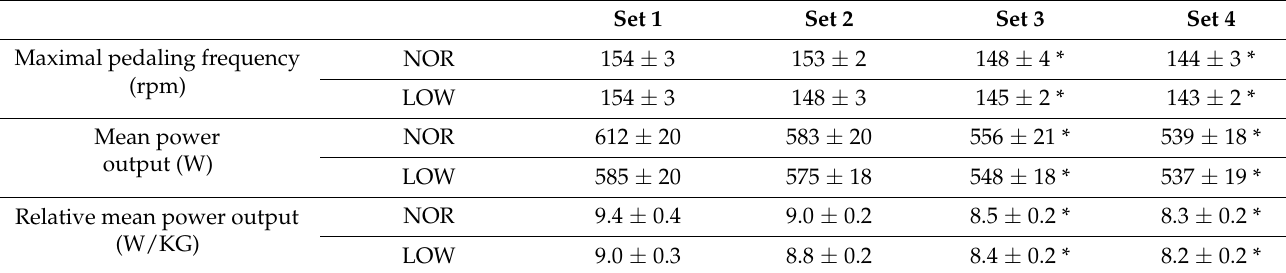
Table 1. Exercise performance variables during repeated sprint